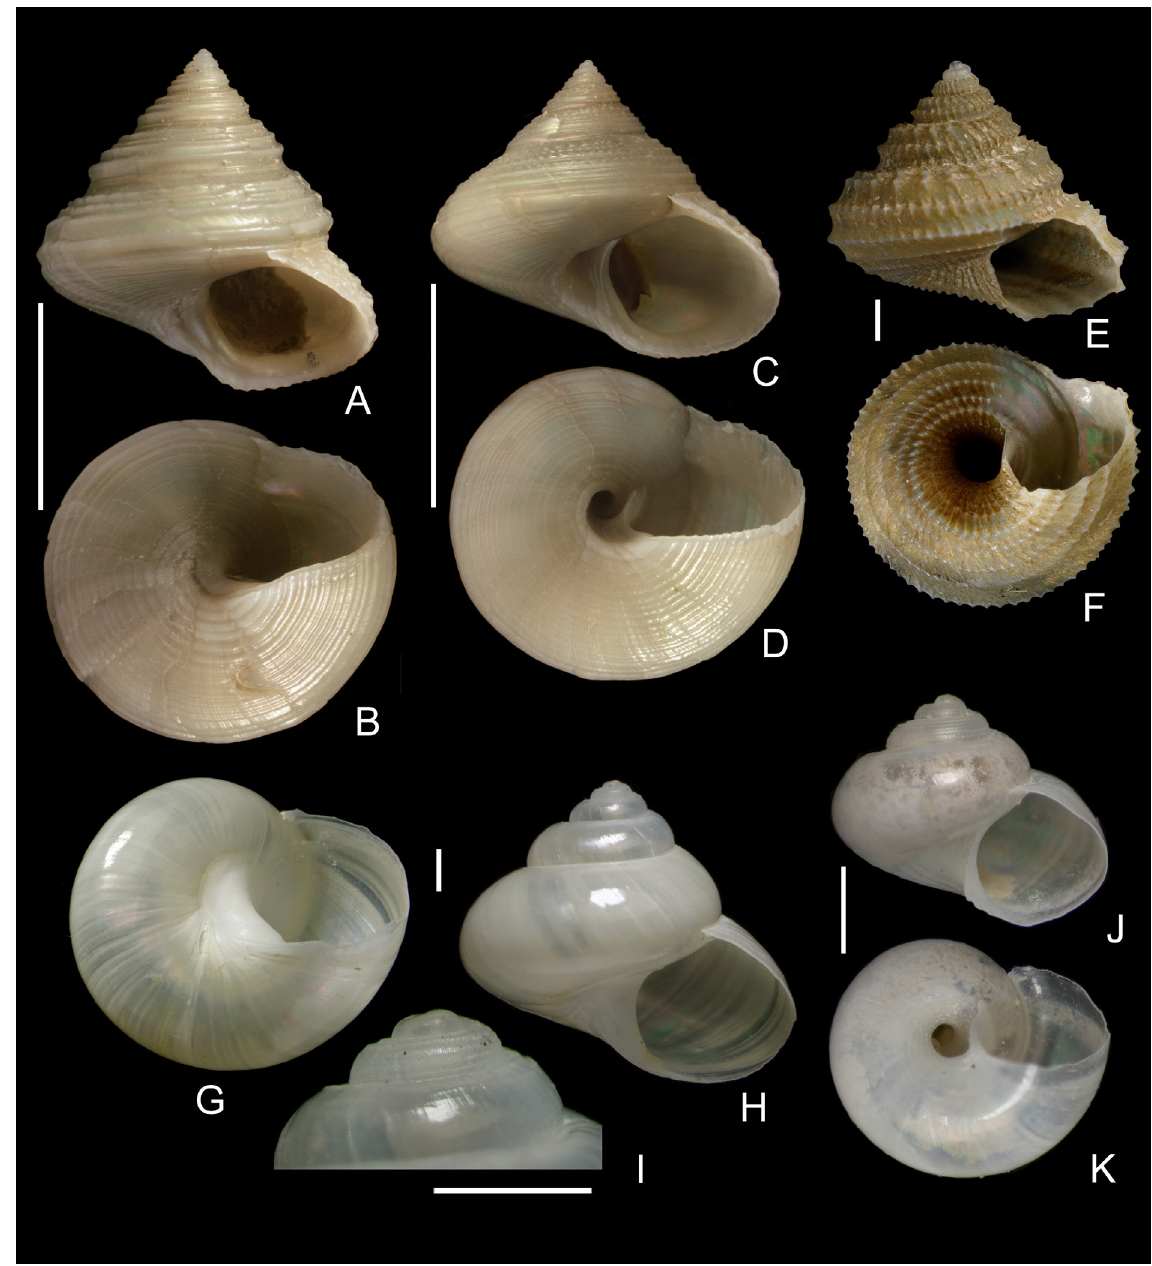
Fig. 11. Trochoidean families. A–B . Calliostoma leptophyma Dautzenberg & H. Fischer, 1896, ECOMARG 0709, V5, 876 m, 16.5 mm. C–D . Calliostoma maurolici (Seguenza, 1876), ECOMARG 0709, V5, 876 m, 15.6 mm. E–F . Calliotropis vaillanti (P. Fischer, 1882), BANGAL 0711, V9, 1671 m, 7.2 mm. G–I . Bathymophila micans (Dautzenberg & H. Fischer, 1896), BANGAL 0711, V8, 1565 m, 8 mm. J–K . B. micans , juvenile shell with open umbilicus, BANGAL 0711, V2, 1706 m, 3.2 mm. Scale bars: A–D = 10 mm; E–K = 1